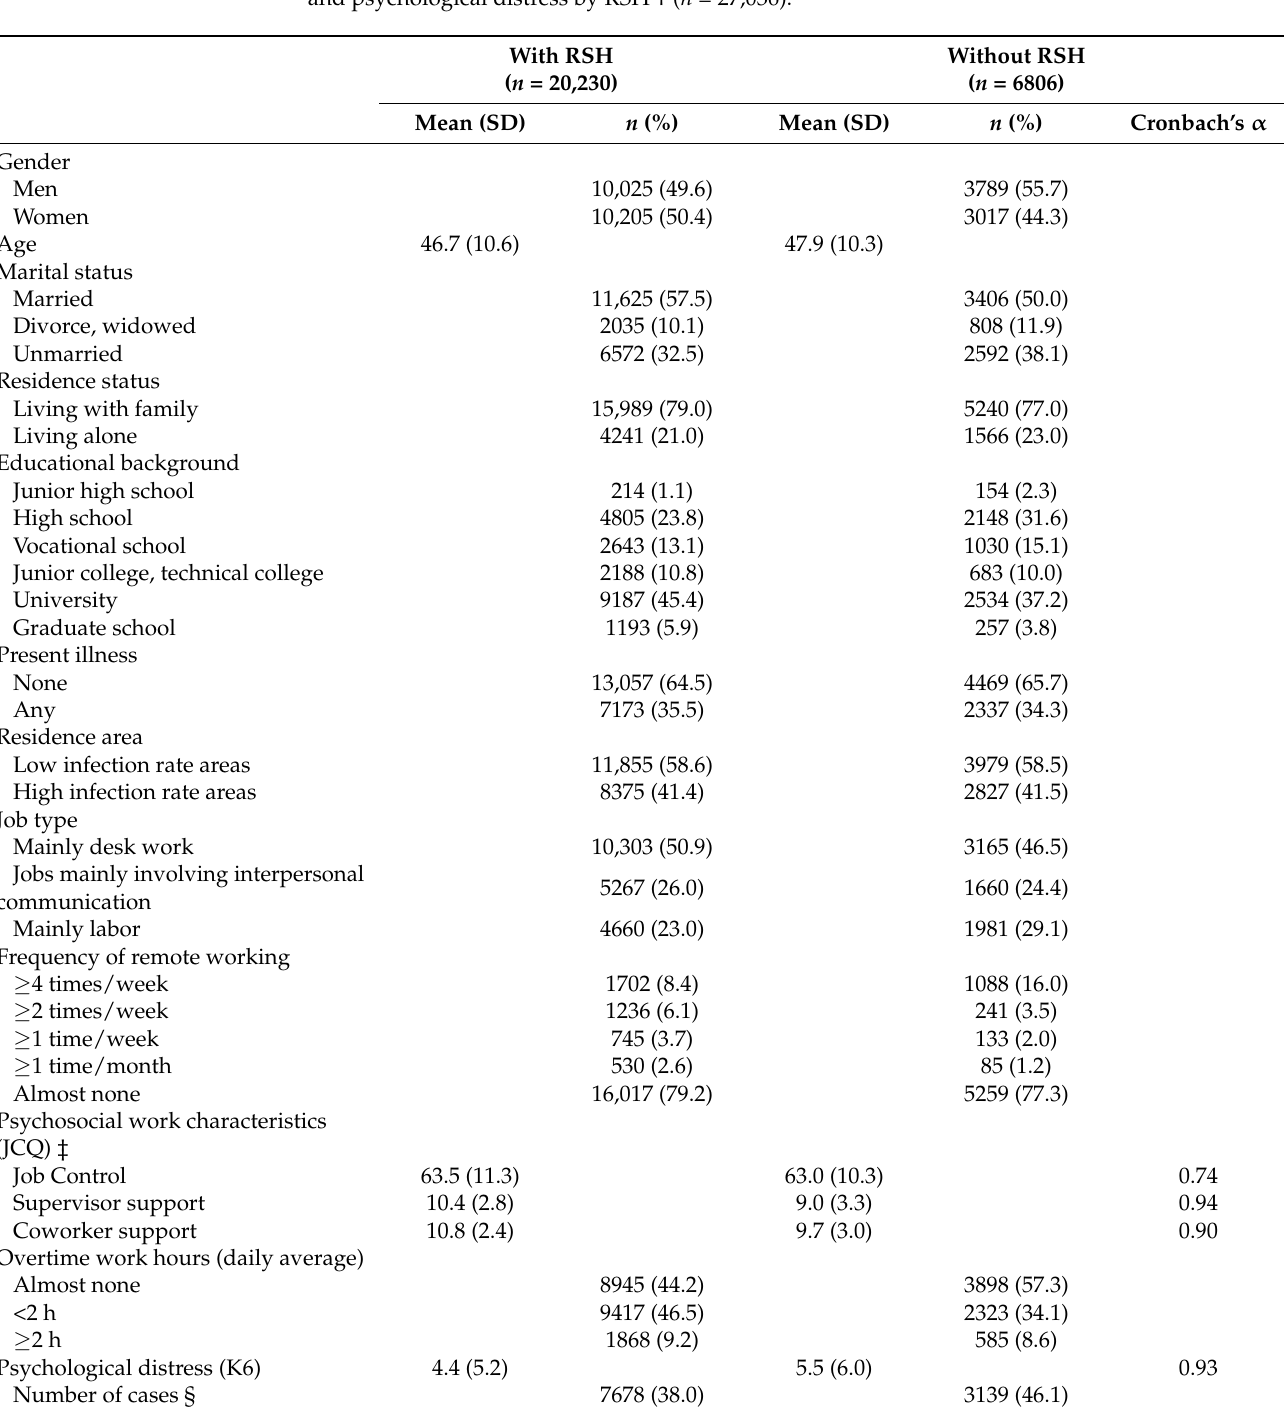
Table 1. Participants’ demographic and occupational characteristics, overtime work hours, and psychological distress by RSH † ( n =